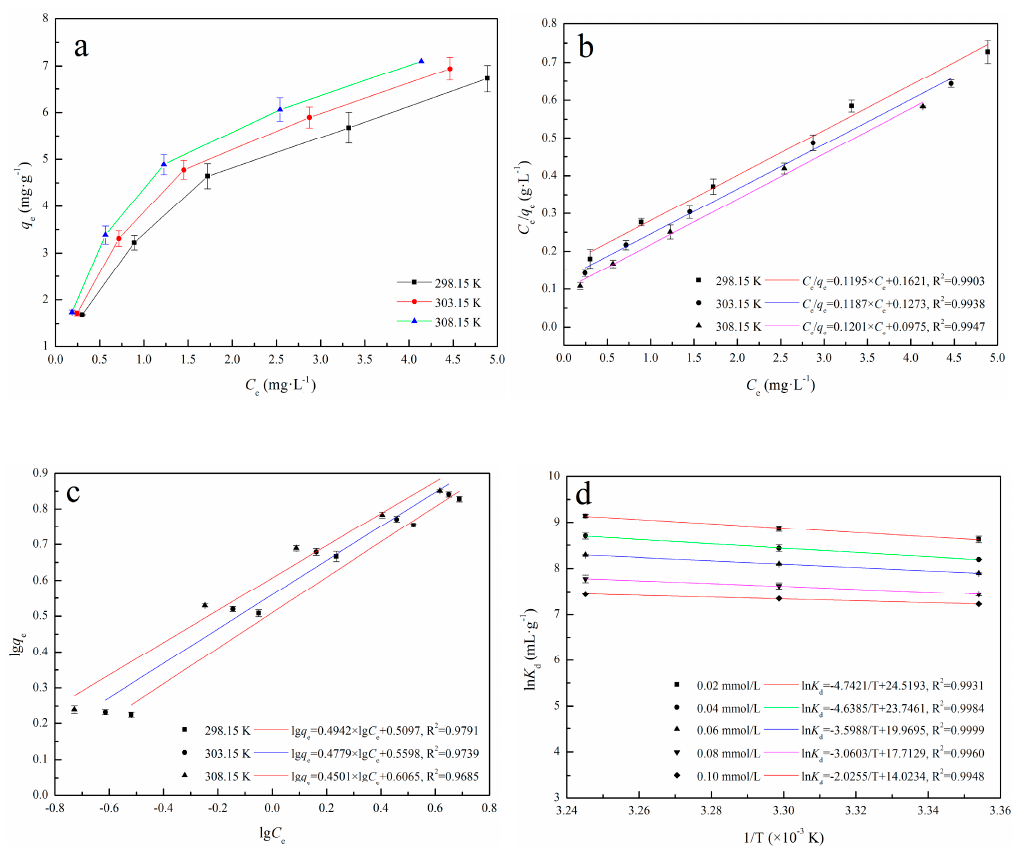
Figure 3. Adsorption isotherms parameters: ( a ) Adsorption isotherms of Cd(II) on IB; ( b ) The fitting line of Langmuir model; ( c ) The fitting line of Freundlich model; ( d ) Plots of ln K d – 1/T of IB.